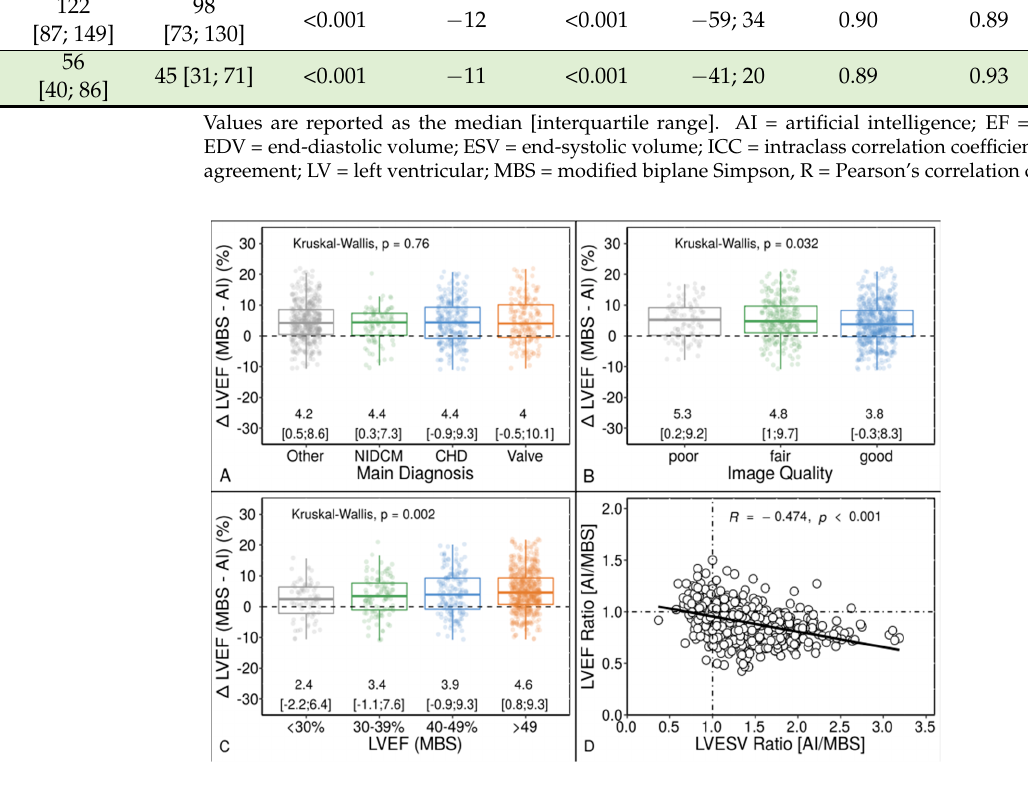
Figure 3. LVEF Bias Grouped by Diagnosis ( A ), Image Quality ( B ), LV Function ( C ), and by Proportion of ESV Overestimation ( D ) between the AI-based application and MBS Method ( N = 889). De- pendency of LVEF bias depicted as boxplots with jittered dots and correlation plot between the AI- based application and MBS technique. CHD = coronary heart disease; Kruskal–Wallis = Kruskal– Wallis test by ranks; NIDCM = non-ischemic dilated cardiomyopathy; Valve = severe valvular heart disease. Other abbreviations as in Figure 2. Table 3. Characteristics of the Main Clinical Diagnosis.